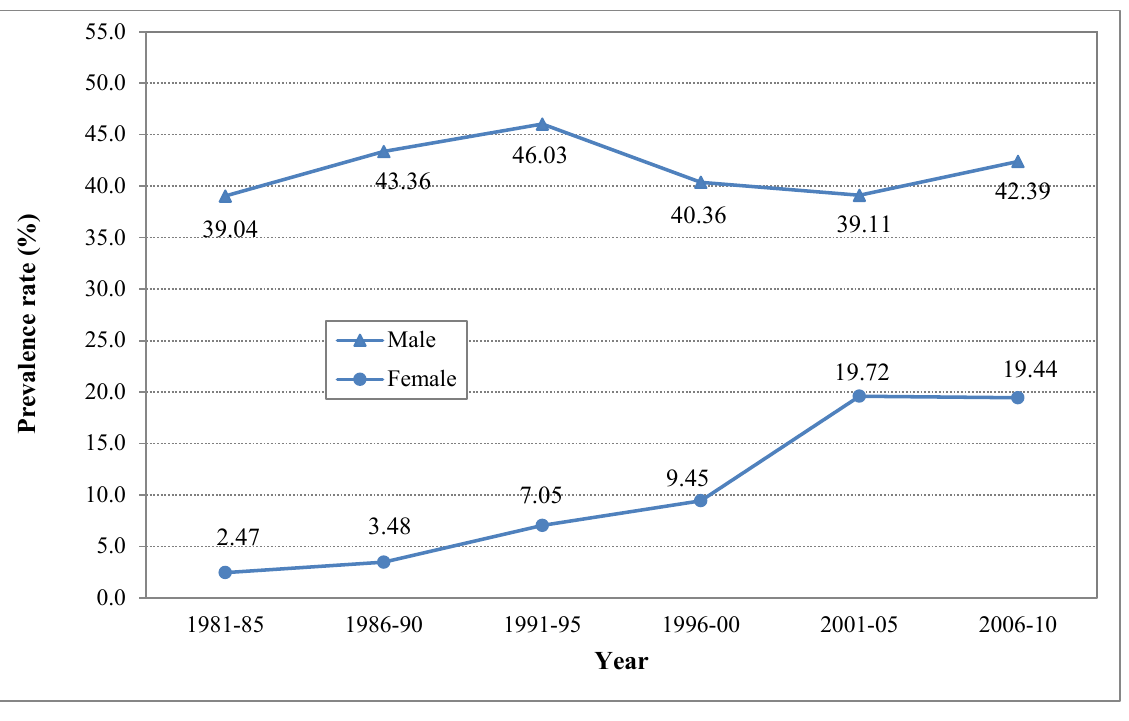
Figure 2. Estimated prevalence rate (%) of lifetime smoking (ever smoked) among adolescents in China, male and female, 1981–2010.